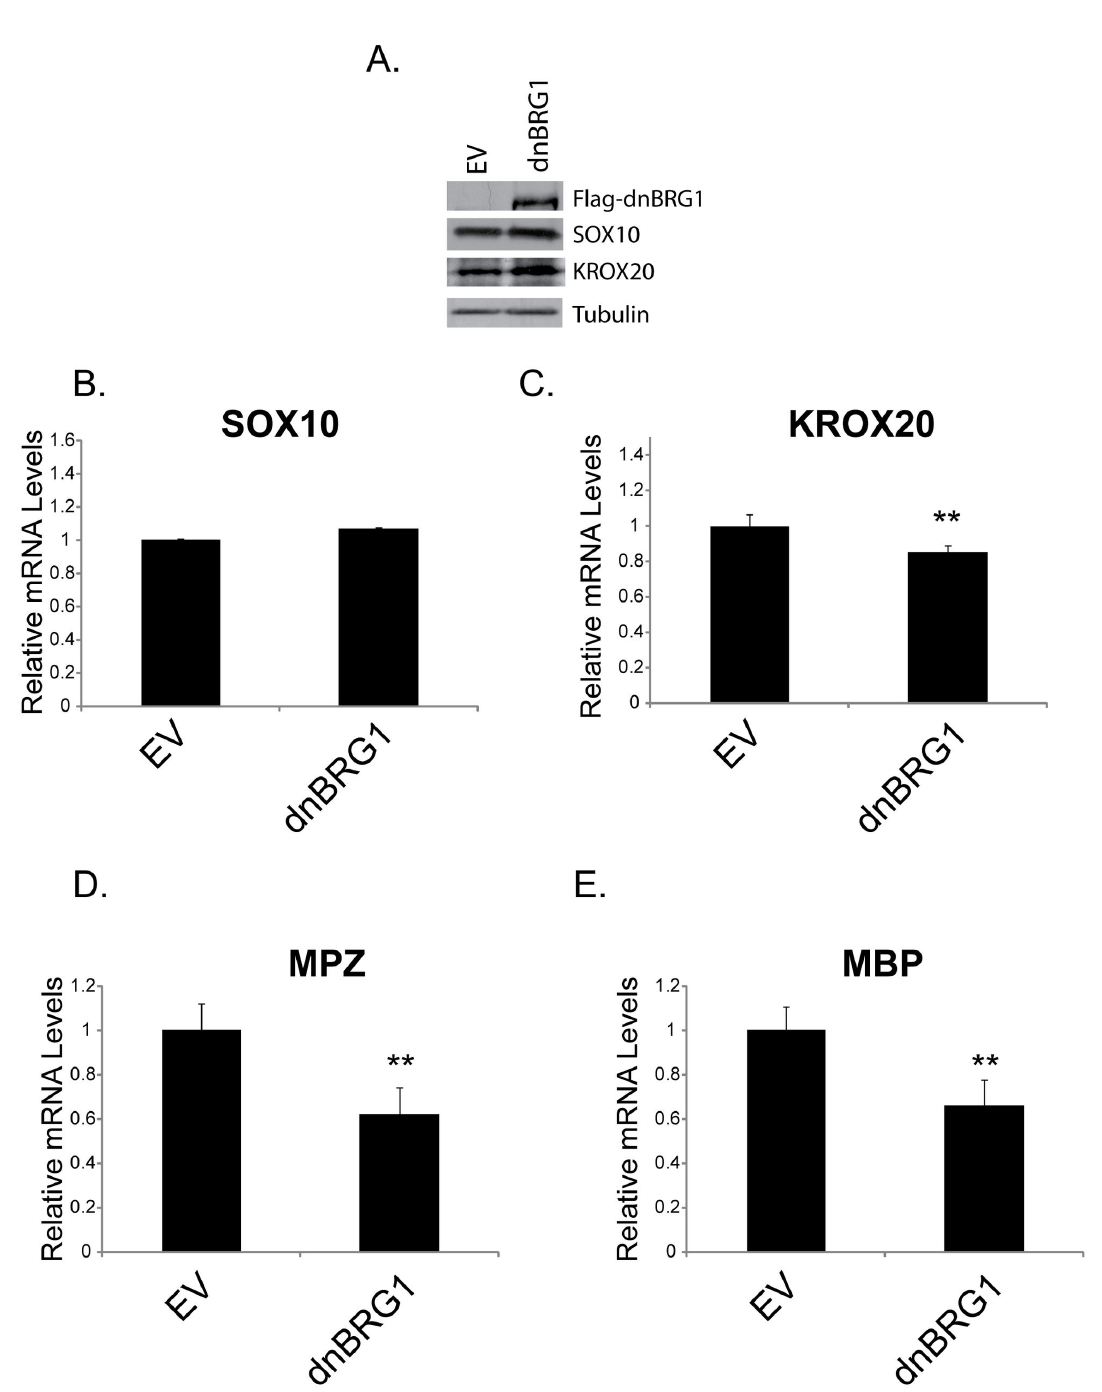
Figure 6. Dominant negative BRG1 inhibits expression of SOX10 target genes in S16 Schwann cells. S16 cells were transfected with GFP (not shown), empty vector (EV), or pBabe-dominant negative BRG1 (dnBRG1). Transfection efficiency was monitored by GFP and was determined to be approximately 30%. (A) Cell extracts were prepared and subjected to Western analysis with antibodies to the Flag epitope, SOX10, or KROX20. Tubulin is shown as a loading control. Quantitative RT-PCR (qRT- PCR) of SOX10 (B), KROX20 (C), MPZ (D), and MBP (E) from empty vector (EV) or pBabe-dnBRG1 transfected cells. Expression of each gene was normalized to that of 18S rRNA. The data are the average of three independent experiments performed in triplicate. Standard error bars are shown (**p<0.01). doi: 10.1371/journal.pone.0069037.g006 PLOS ONE |